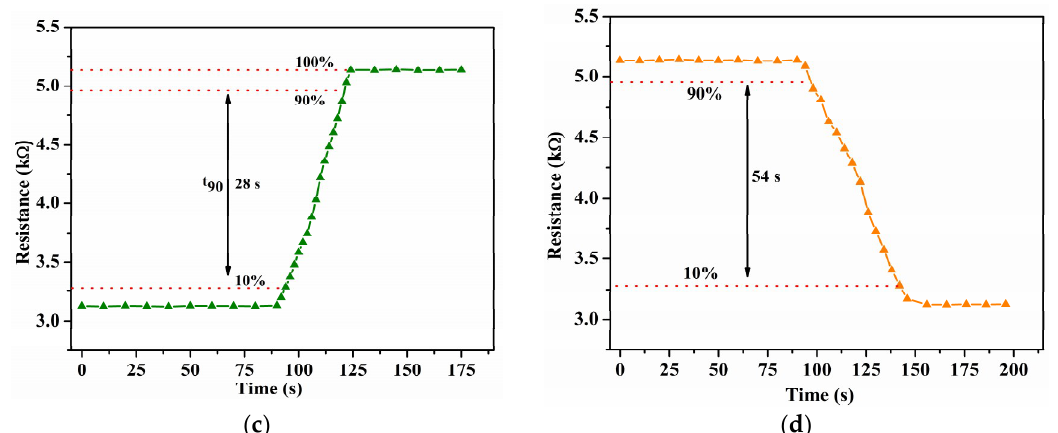
Figure 3. ( a ) Response time and ( b ) recovery time of the suspended CNTs; ( c ) response time and ( d ) recovery time of the non-suspended CNTs. The humidity was increased gradually in steps of 10% RH.